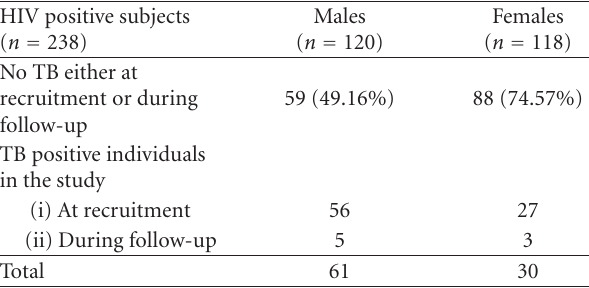
Table 1: Occurrence of TB amongst HIV positive